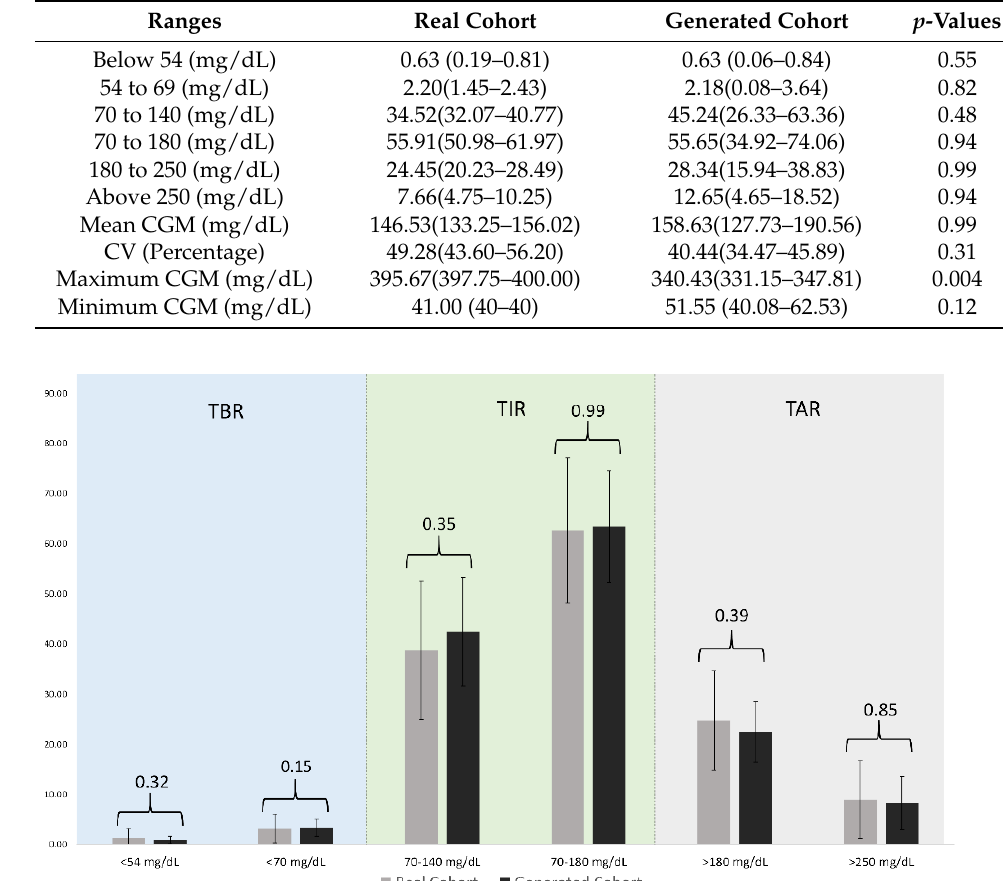
Figure 9. Times in standardized ranges of blood glucose for real and generated cohorts with corre- sponding p -values of the Ohio 6 patient data set. 5. Discussion The proposed system demonstrated that, first, our Pix2Pix GAN learned from the distributions of BG profiles of diabetic patients labeled with plasma insulin estimation and, second, that it is able to generate new BG values conditioned on plasma insulin val- ues. The generated BG values showed statistical similarity with the original data set. Since the model was trained and tested with two different data sets, the results for both data sets confirmed the effectiveness of our method. However, it is important to note that the approximation was better for the 29 patients’ data set as compared to the 6 patients’ data set, confirming that the amount of data used for training is a significant performance con- straint. The need for more data, though paradoxical when it comes to data generation, is also evident from the theory of GANs [38]. Since, we used a variant of GAN that performs the task of image translation, the nu- merical data was transformed into graphical data in order to be used with the GAN. This